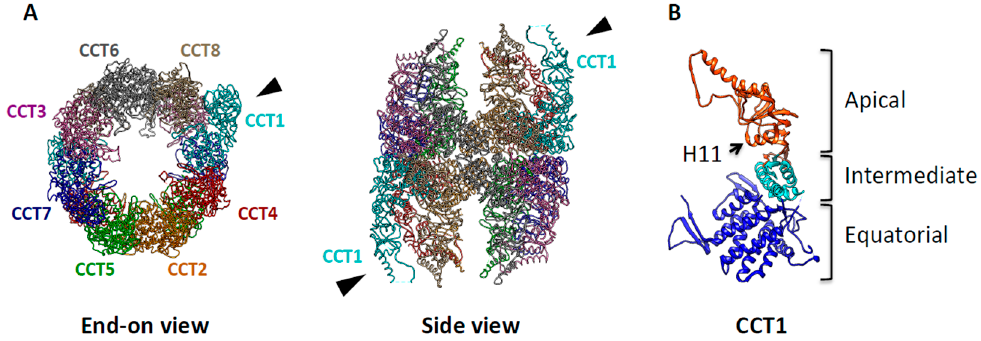
Figure 2. Molecular architecture of TRiC/CCT. ( A ) The end-on and side views of the X-ray crystal structure of TRiC, modified from PDB ID 2XSM, show that TRiC is a double-ringed structure composed of eight homologous but distinct subunits (CCT1–8). Each subunit is shown having a different color with the specific subunit order indicated. The black arrowhead indicates CCT1, which has unique asymmetrical features; ( B ) The X-ray structure of CCT1 is shown as a representative subunit. Helix-11 (H11), the putative substrate recognition site is indicated by the arrow.